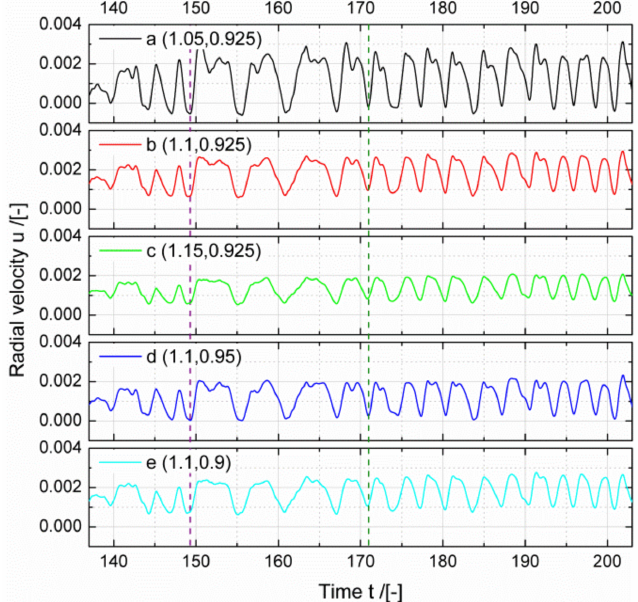
Figure 6. Variation of radial velocity at monitoring points ( Ca C = − 0.01, R = 2.5 mm, H/R = 1.0, Vr = 1.0).